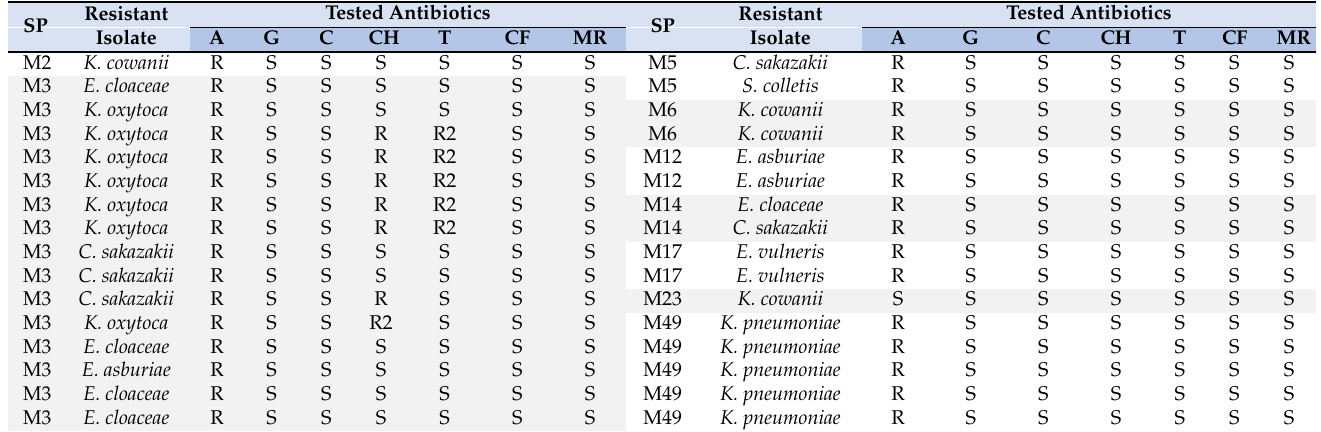
Table 8. Antibiotic-resistant profiles of isolated resistant coliform bacteria against selected types of antibiotics. Tested Antibiotics Tested Antibiotics